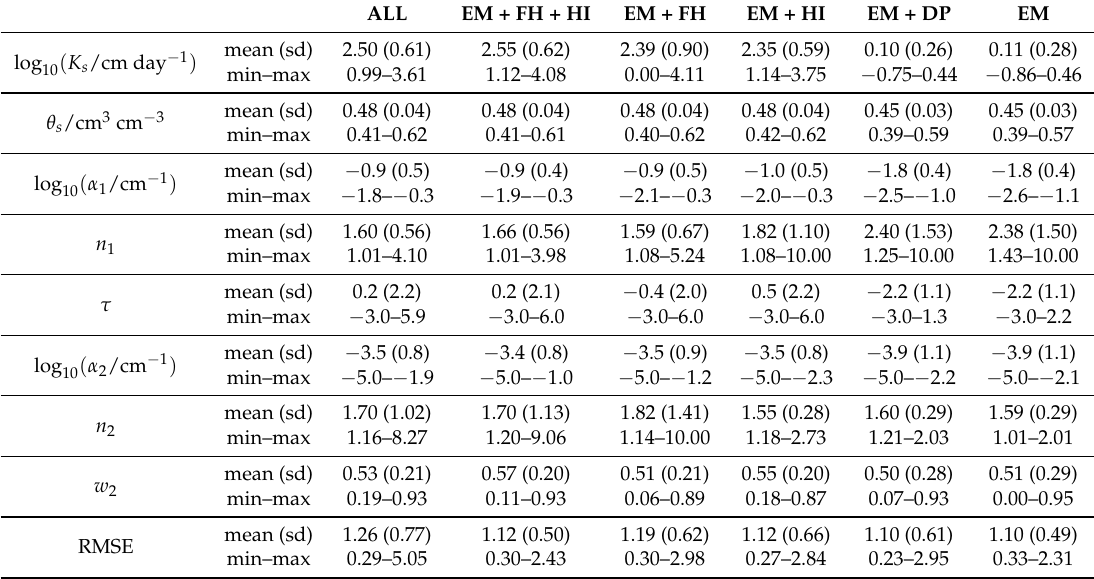
Table 4. Fitted parameters of bimodal van Genuchten-Mualem model and evaluation criterion root mean square error (RMSE).